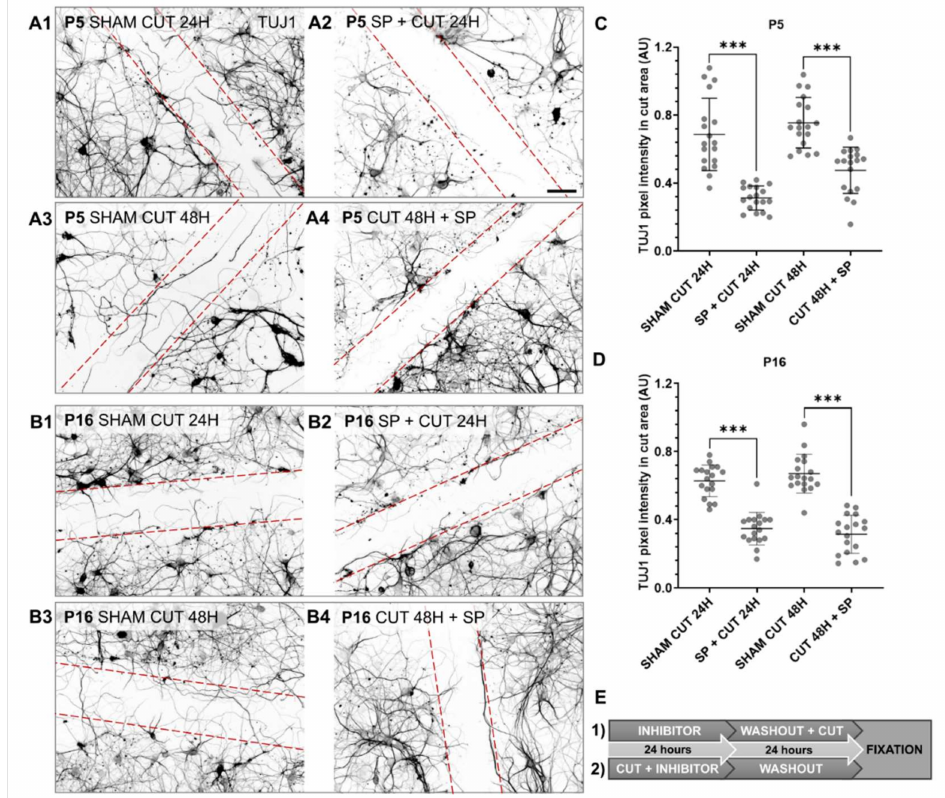
Figure 7. Prolonged effect of ATF3 inhibition on neurite outgrowth. ( A1 – A4 ) Cortical neurons derived from P5 opossum. ( A1 , A3 ) represent control neuronal cultures treated with PBS only. At DIV10, neurons were first treated with SP inhibitor for 24 h, followed by scratch and washout for the next 24 h ( A2 ), or incubated with SP immediately after scratch over the next 24 h and followed by 24 h washout ( A4 ). ( B1 – B4 ) Cortical neurons derived from P16 opossum. ( B1 , B3 ) represent control neuronal cultures treated with PBS only. At DIV10, neurons were first treated with SP inhibitor for 24 h, followed by scratch and washout for the next 24 h ( B2 ), or incubated with SP immediately after scratch over the next 24 h and followed by 24 h washout ( B4 ). Neurons were fixed and immunostained for TUJ1. The scratch area is defined by the red dashed lines. Scale bar is 50 µ m. ( C ) The scatter plot shows P5 average TUJ1 pixel intensity. Data are shown as mean ± SD. For each condition, 2 ROIs of 3 random fields per sample from 3 culture preparations were analyzed. Welch’s t -test, SHAM CUT 24H vs. SP + CUT 24H p < 0.001 ***. Unpaired t -test, SHAM CUT 48H vs. CUT 48H + SP p < 0.001 ***. ( D ) The scatter plot shows P16 average TUJ1 pixel intensity. Data are shown as mean ± SD. For each condition, 2 ROIs of 3 random fields per sample from 3 culture preparations were